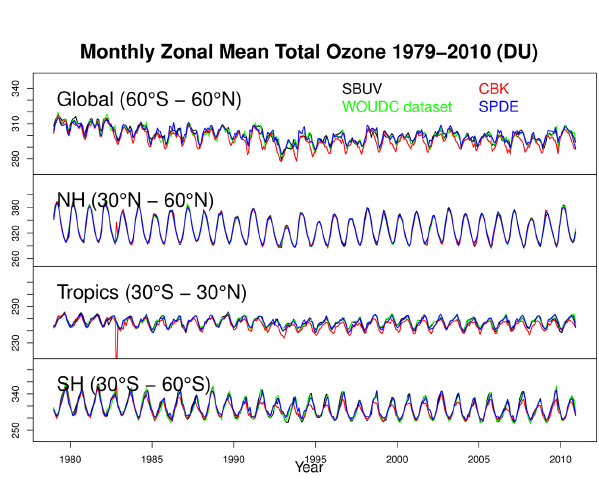
Figure 8. Time series of zonal means by SBUV satellite data (black) WOUDC data set (green), covariance-based kriging (red) and SPDE (blue) from 1979 to